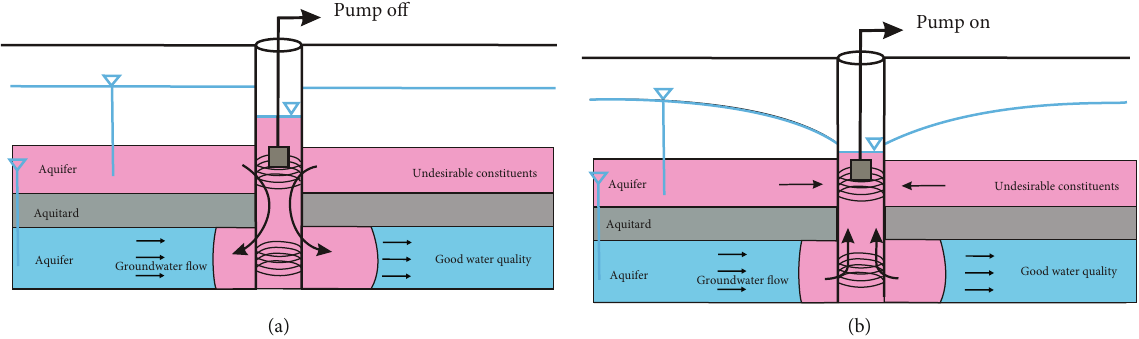
Figure 1: The schematic of well that acts as a preferential fl ow pathway: (a) vertical fl ow and contaminant migration through a well with regional groundwater fl ow in inactive phase; (b) deterioration of water quality in pumping phase with regional groundwater fl ow.